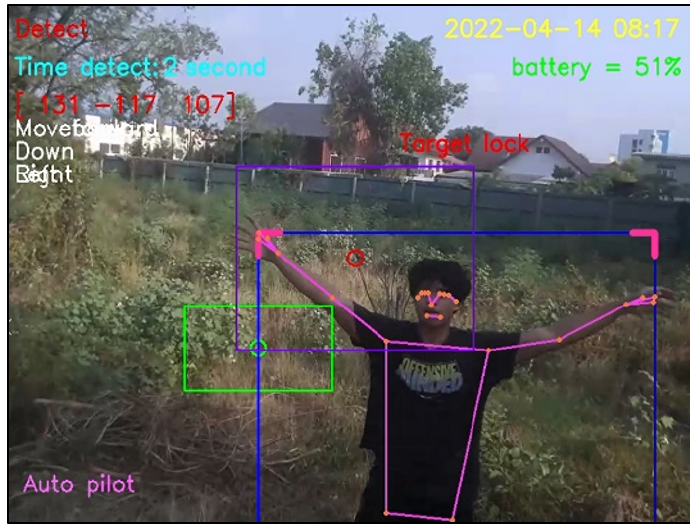
Figure 28. True positive